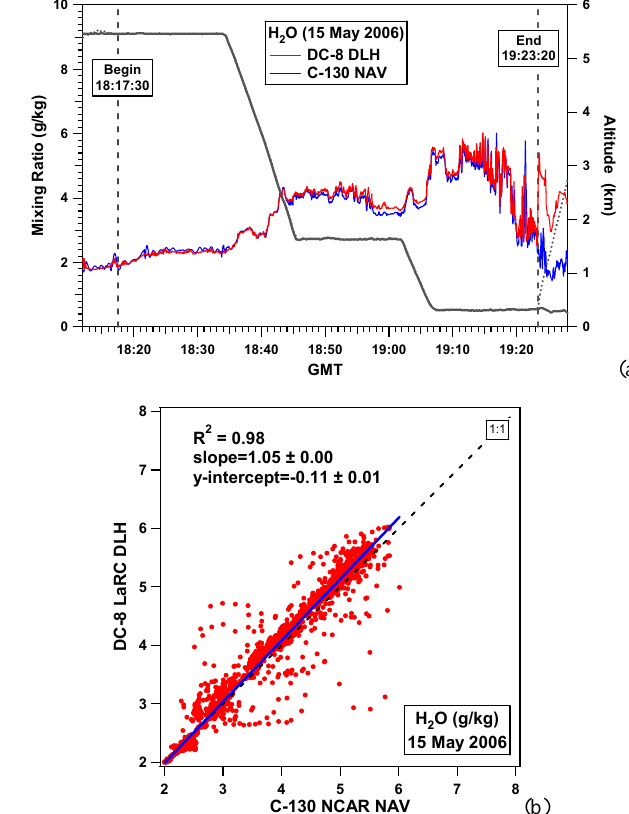
Fig. 2. (a) Timeseries for ozone during the intercomparison portion of the 19 March 2006 flight. The dotted line indicates the DC-8 altitude, solid thick line the C-130 altitude, red line DC-8 ozone, and blue line C-130 ozone. (b) Scatter plot and orthogonal dis- tance regression for the DC-8 and C-130 ozone intercomparison on 19 March 2006.